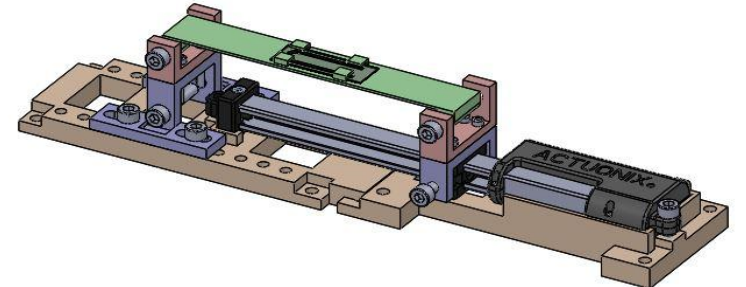
Figure 1. 3D representation of the mechanical structure of the test bench for the characterization of sensors for applications with variable radius of curvature.